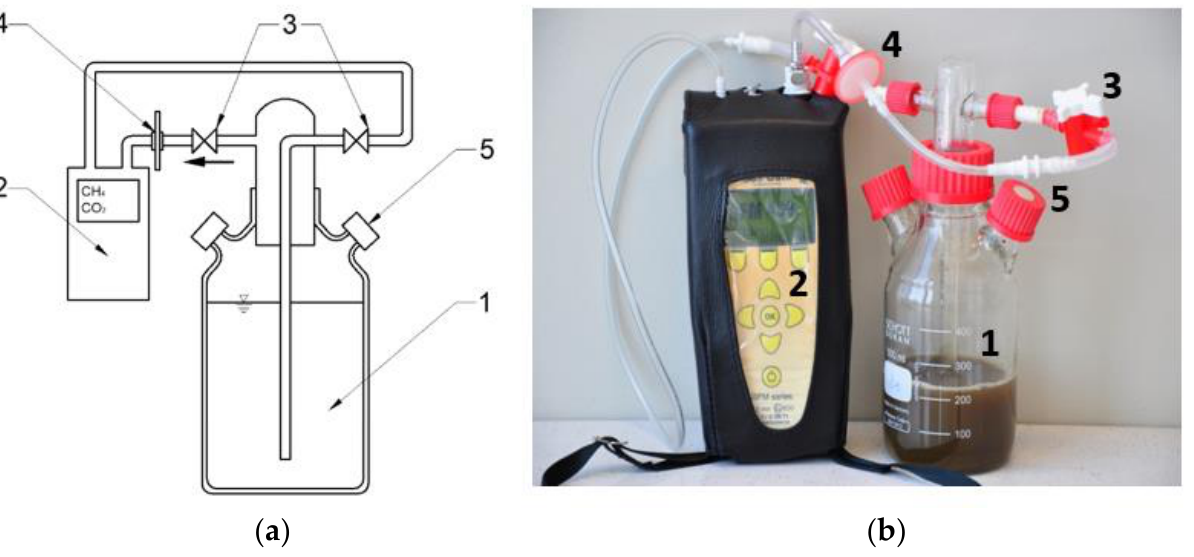
Figure 12. Diagram ( a ) and photograph ( b ) of a model respirometric fermentation chamber with a system for biogas quality analysis (1 — fermentation chamber, 2 — biogas composition analyzer, 3 — valves cutting off biogas flow, 4 — biogas dryer, 5 — gas-tight port for sample collection for chromatographic analyses).